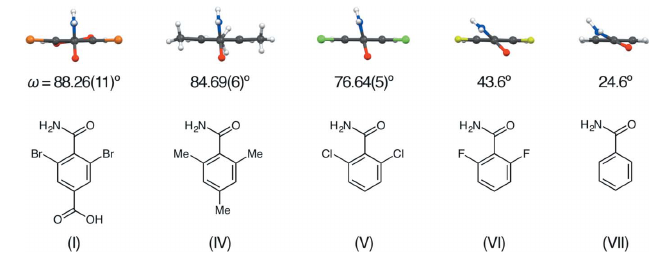
Figure 4 Substituted benzamides, in their crystals, viewed along carbamoyl group ipso bonds. The listed dihedral angles ( ! ) are between the best-fit planes of the respective benzene rings and carbamoyl groups.